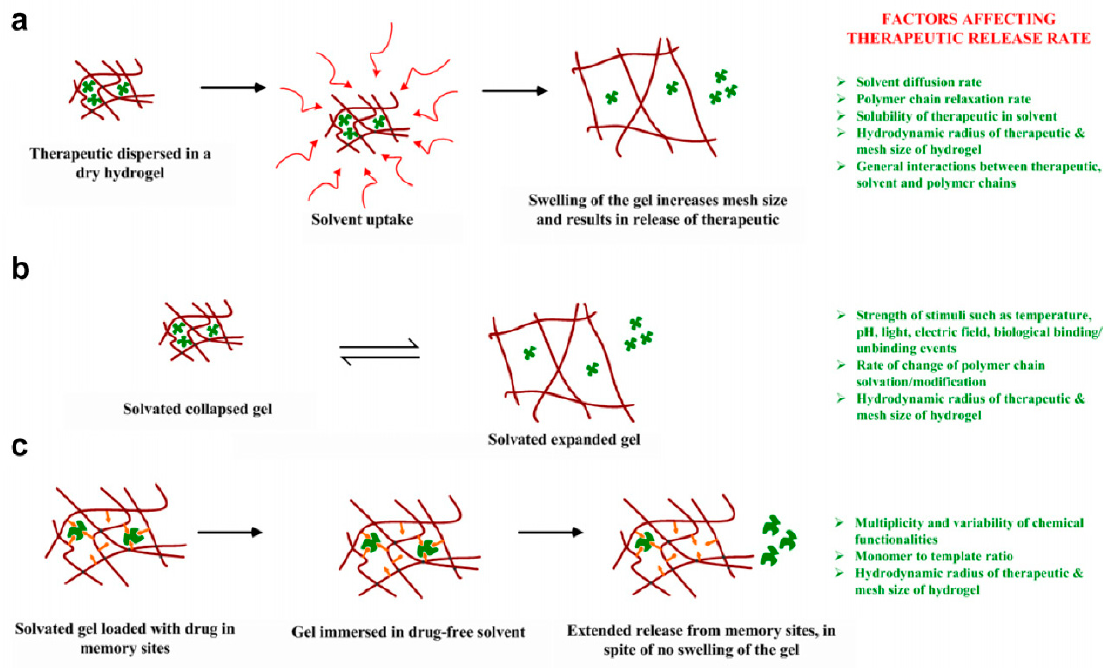
Figure 10. Scheme of ( a ) controlled drug release in hydrogels upon their swelling either by solvent uptake from a dry state or ( b ) thermodynamic compatibility with the solvent. ( c ) Macromolecular memory is obtained by imprinting a multifunctional pre-polymerization complex with the drug as an alternative strategy to release the drug in a controlled fashion when the gels are already solvated and fully swollen . Reprinted from [38], Copyright (2022), with permission from Elsevier [or applicable society copyright owner] .